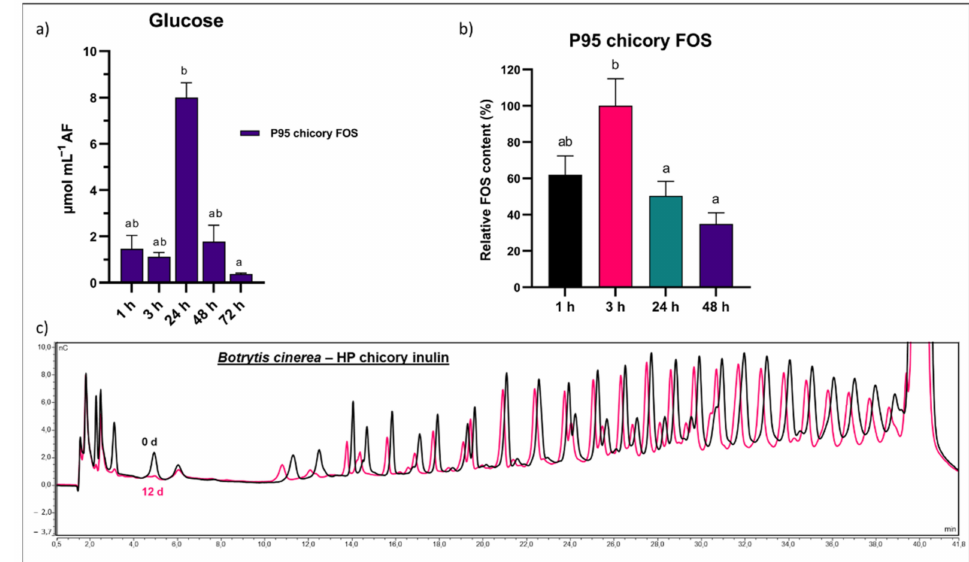
Figure 10. Apoplastic FOS dynamics after priming in rocket leaves. Apoplastic fluid (AF) was extracted from rocket leaves at different time points after priming. ( a ) Apoplastic Glc levels were measured at different time points after FOS priming. ( b ) FOS levels in AF at different time points after FOS priming. Bars represent the mean ± SEM. A minimum of 6 biological replicates was used per treatment. The experiment was repeated 2 times with consistent results. Letters indicate significant differences between time points ( p < 0.05). ( c ) Incubation of B. cinerea in minimal medium supplemented with HP chicory inulin. Inulin degradation and consumption by the fungus were ana- lyzed on HPAEC-IPAD after 12 d. X-axis shows retention time (min), y-axis indicates amperometric signal